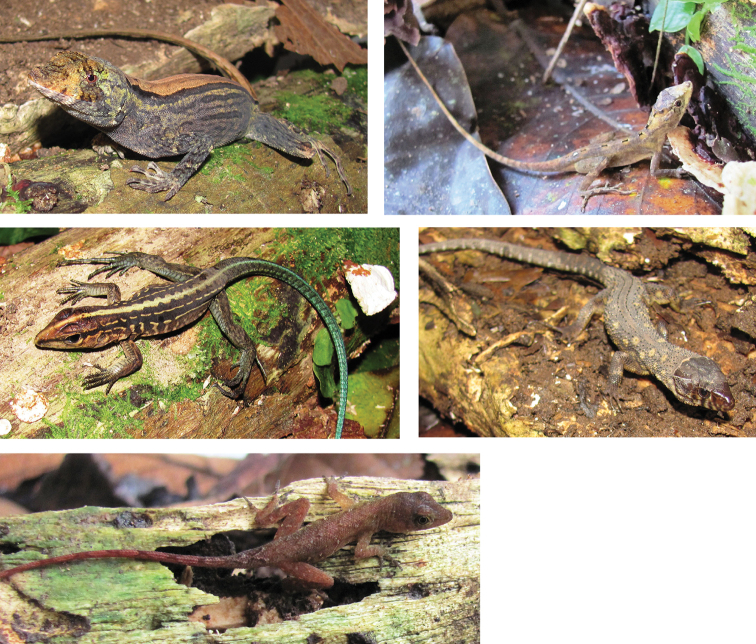
Some lizard species analyzed in present study (Photos by Riccardo Castiglia) AAnolis
capitoBAnolis
lemurinusCHolcosus
festivusDLepidophyma
flavimaculatumEAnolis
uniformis.